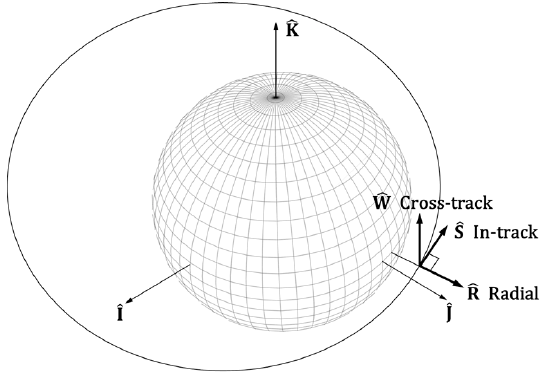
Figure 2. Conceptual diagram to show the definition of the radial, in-track, cross-track (RIC) frame.